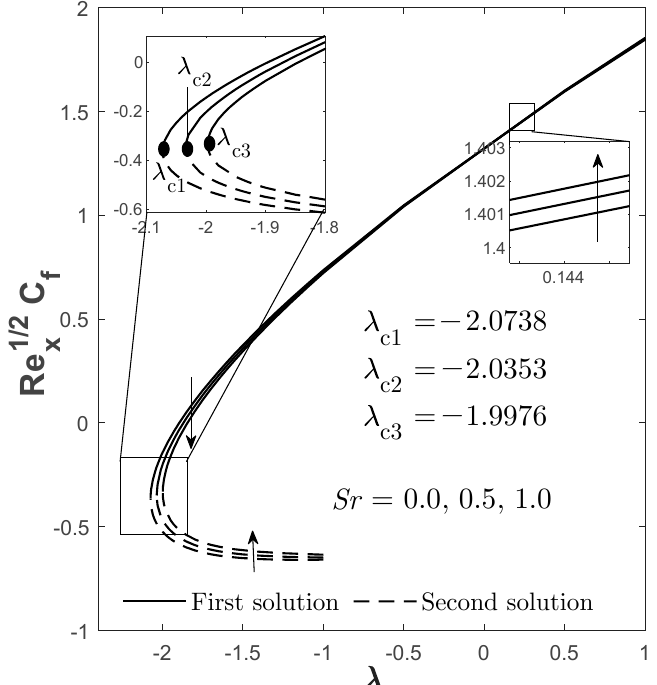
Figure 8. for varied Sr when Figure 8. Re 1/2 x C f for varied Sr when N = Rd = Sc = 1, φ 2 = 0.01, Du = 0.03, and Bi = 0.1. Figure 8.